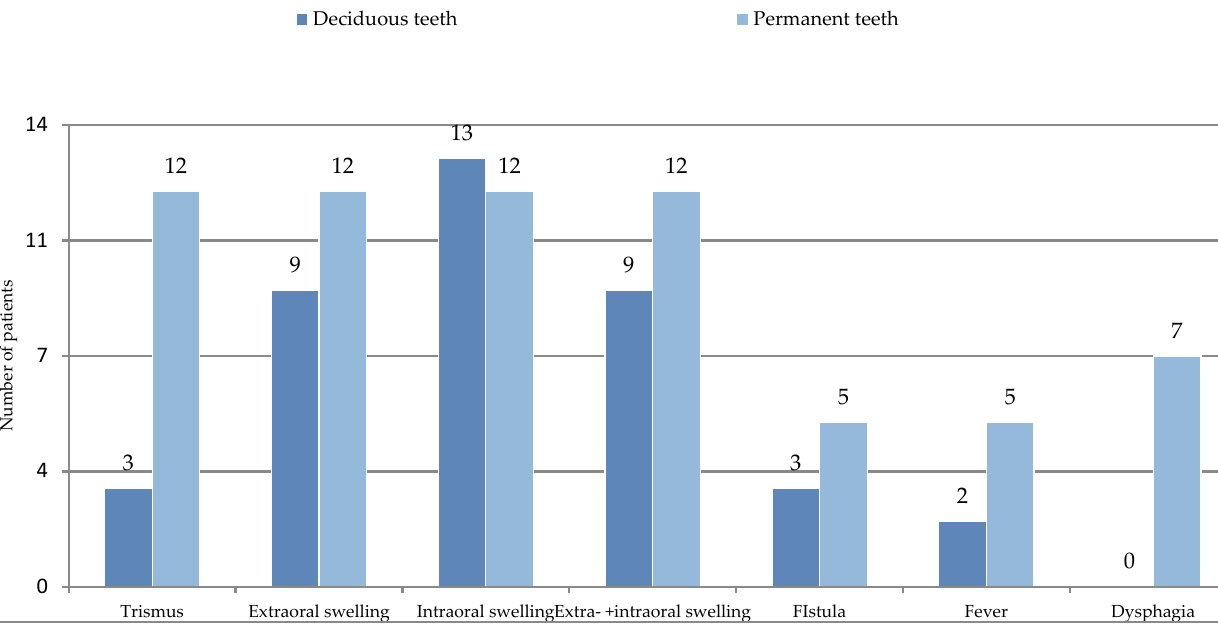
Figure 4. General symptoms in odontogenic infections of deciduous and permanent teeth.